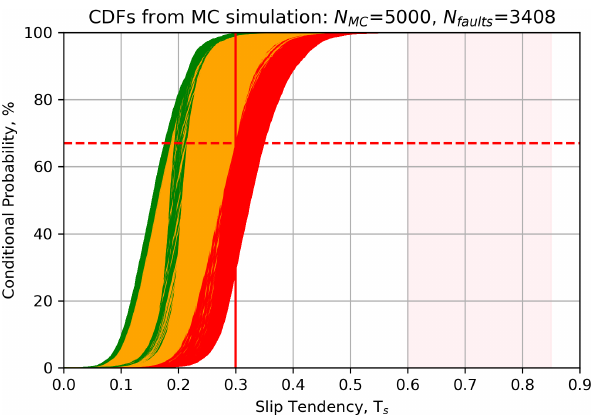
Figure 16. Output from the Monte Carlo modelling of slip tendency ( T s ) in South Wales coalfield, UK. For slip tendency, more stable faults skew towards the left (low T s ), less stable faults skew to the right (high T s ). CDFs of predicted slip tendency for each mapped fault in South Wales. Colour coding of CDFs is as follows: red shows > 33% chance of exceeding threshold friction ( µ = 0 . 3, ver- tical red line), amber shows between > 1% and < 33% chance, and green shows < 1% chance. The range of Byerlee friction is shown by pink shading.